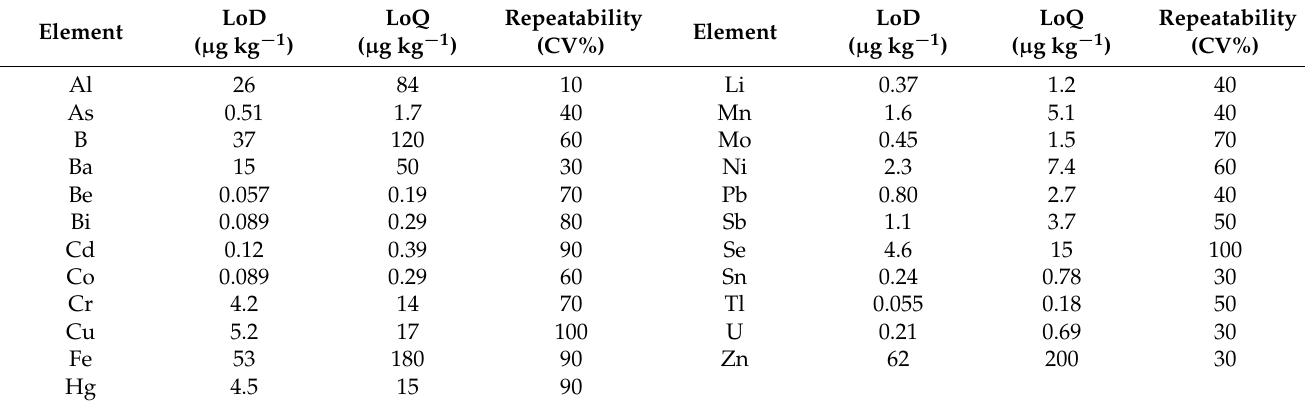
Table 2. Validation parameters for the ICP-MS determination of the total amount of 23 toxic elements and oligoelements in